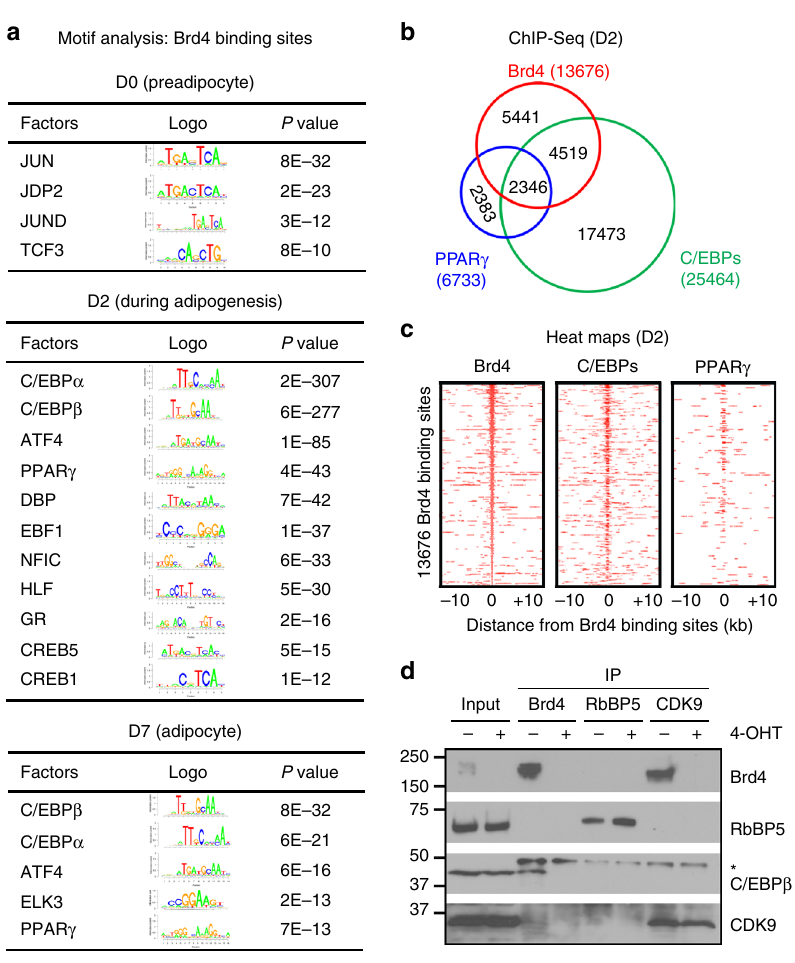
Fig. 4 Genomic co-localization of Brd4 with LDTFs during adipogenesis. a Motif analysis of Brd4 binding regions in adipogenesis. Only TFs that are expressed at the indicated cell stages are presented. b , c Venn diagram b and heat maps c of genomic co-localization of Brd4 with C/EBPs (C/EBP α or β ) and PPAR γ at D2 of adipogenesis. Published ChIP-Seq data sets for C/EBP α / β and PPAR γ were used (GSE74189) 24 . d Brd4 physically interacts with C/ EBP β during adipogenesis. SV40T-immortalized Brd4 f/f #2 ; Cre-ER brown preadipocytes were treated with 4-hydroxytamoxifen (4-OHT) to induce the deletion of exon 5 of Brd4 gene. Immunoprecipitation (IP) of Brd4, RbBP5, and CDK9 was done in nuclear extracts prepared at D2 of adipogenesis. The immunoprecipitates were analyzed by western blot using antibodies indicated on the right. The asterisk (*) indicates IgG heavy